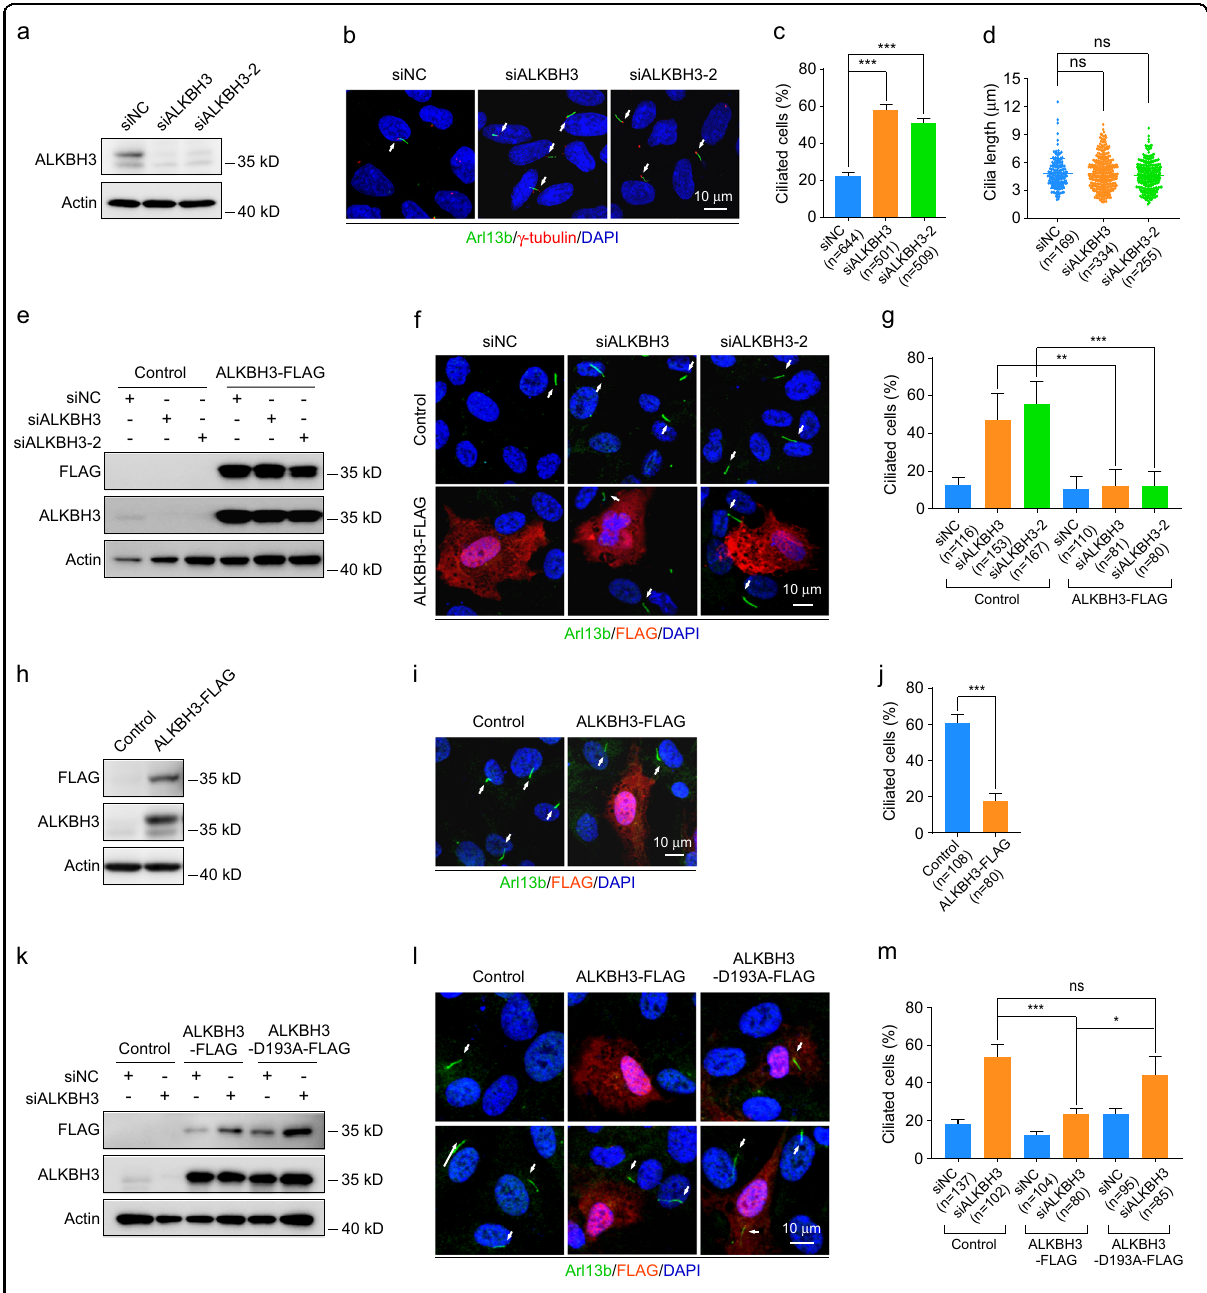
Fig. 1 ALKBH3 inhibits ciliogenesis through its m 1 A demethylation activity. a – d RPE-1 cells were transfected with control or ALKBH3 siRNAs for 48 h in DMEM/F12 medium with 10% serum (normal conditions) and then subjected to western analysis or immuno fl uorescence. Western blotting of ALKBH3 protein ( a ). Representative images of RPE-1 cells with anti-Arl13b (green) and γ -tubulin (red) antibodies ( b ). Quanti fi cation analysis of the percentage of ciliated cells ( c ). Cilia length was determined by Image J software ( d ). e – g , k – m RPE-1 cells treated with the indicated siRNAs for 24 h were transfected with control, ALKBH3-FLAG, or ALKBH3-D193A-FLAG plasmid for another 24 h in normal conditions, and then subjected to western analysis or immuno fl uorescence. h – j RPE-1 cells transfected with the indicated plasmids for 24 h in normal conditions were treated with serum starvation for another 24 h and then applied for western analysis or immuno fl uorescence. Western blotting of FLAG and ALKBH3 protein was presented ( e , h , k ). Representative confocal images of RPE-1 cells with anti-Arl13b (green) and anti-FLAG (red) antibodies were shown ( f , i , l ). The percentage of ciliated cells in control or FLAG-positive group was analyzed ( g , j , m ). Actin was served as a loading control. DNA was stained by DAPI (blue). Cilia are indicated by white arrows. Scale bars, 10 μ m. n, the number of total cells calculated. Data are presented as the means ± SD from at least three independent experiments. Student ’ s t- test; ns not signi fi cant; * P < 0.05, ** P < 0.01, *** P <